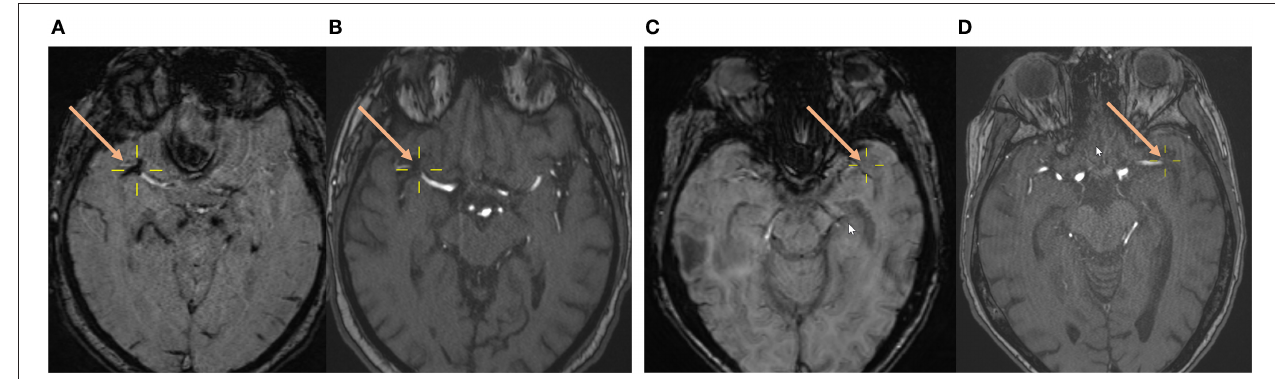
FIGURE 1 | Assessment of the susceptibility vessel sign status on baseline brain MRI. (A,B) A 74-year-old male patient with AIS and visible SVS as a circumscribed signal loss on the SWI (A) with complete occlusion of the right MCA (M1 segment) on arterial TOF (B) . (C,D) A 77-year-old female patient with AIS and absent SVS on the SWI (C) despite complete occlusion of the left MCA (M1 segment) on arterial TOF (D) . Yellow crosshairs and salmon arrows center, respectively, point to the proximal part of the vessel occlusion on SWI and TOF. AIS, acute ischemic stroke; MCA, middle cerebral artery; SVS, susceptibility vessel sign; SWI, susceptibility-weighted imaging; TOF, time-of-flight